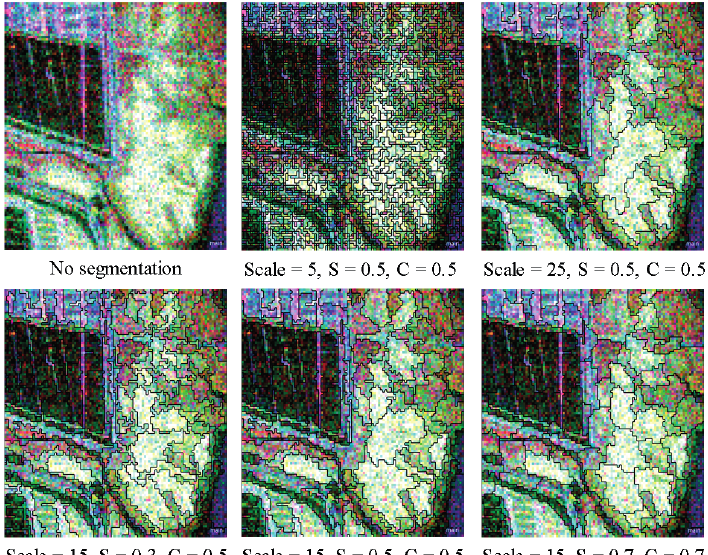
Figure 4. Determining the optimal scale for the Pauli RGB image